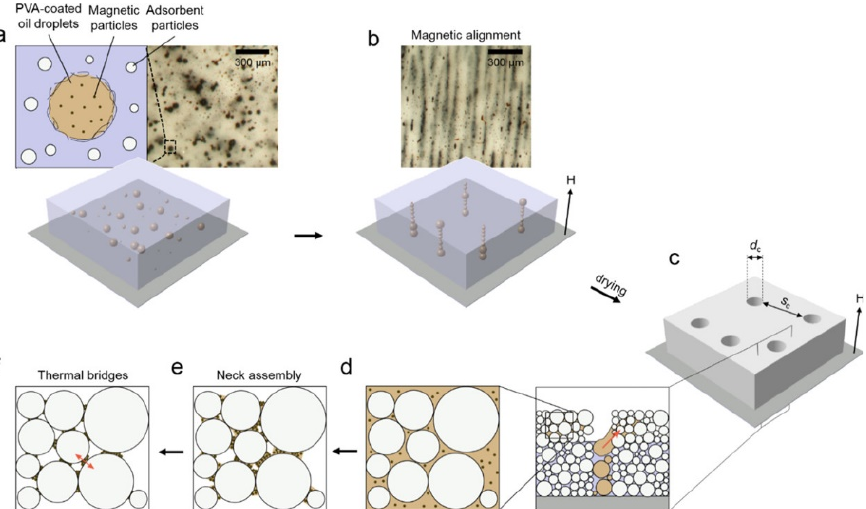
Figure 9. Schematics of the colloidal assembly process used for the manufacturing of architectured adsorbent coatings. ( a ) Aqueous suspension containing adsorbent zeolite particles (SAPO-34) and ferrofluid oil droplets is first deposited on an aluminum substrate; ( b ) Magnetic field applied normal to the substrate aligns the oil droplets into vertical chains; ( c ) Drying under the field leads to an adsorbent structure with open vertical channels; ( d , e ) Capillary forces developed during drying cause ( d ) drainage of the ferrofluid droplets into the packed zeolite particles and ( e ) the formation of capillary bridges at the particle contact points; ( f ) Remaining iron oxide nanoparticles form necks between the zeolite particles, leading to a percolating network with improved thermal conductivity. Reprinted/adapted with permission from Ref. [110]. (Copyright 2019), ACS.